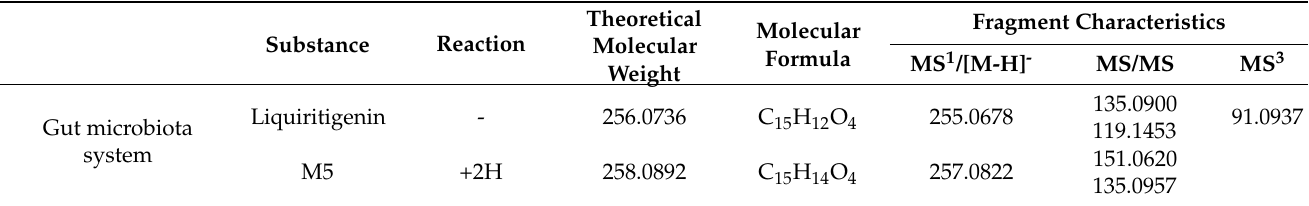
Table 1. Characteristics of the liquiritigenin metabolites from the gut microbiota system by LC/MS n -IT-TOF.